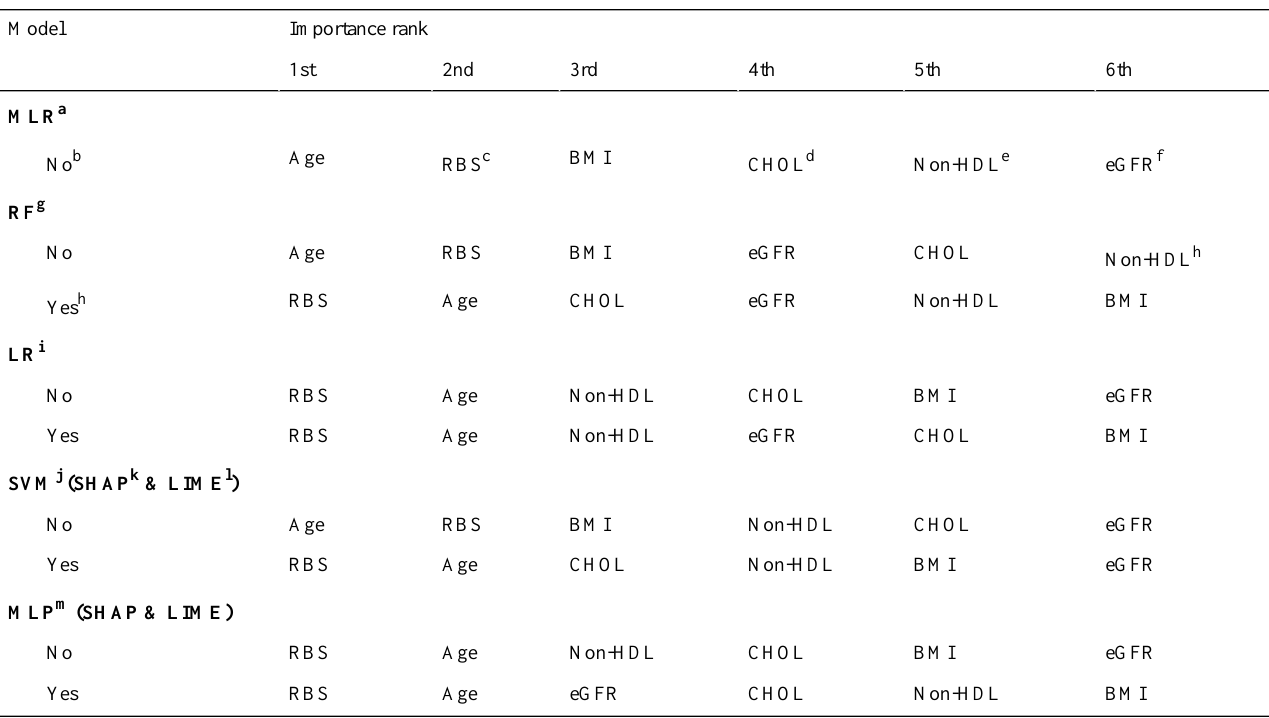
Table 4. Order of importance of predictors for the models.